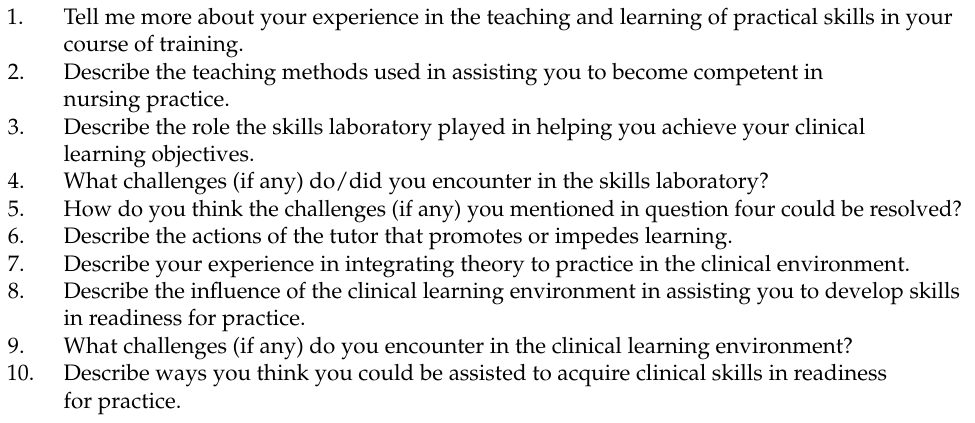
Table 1. Topic guide for focus group discussions on clinical competence